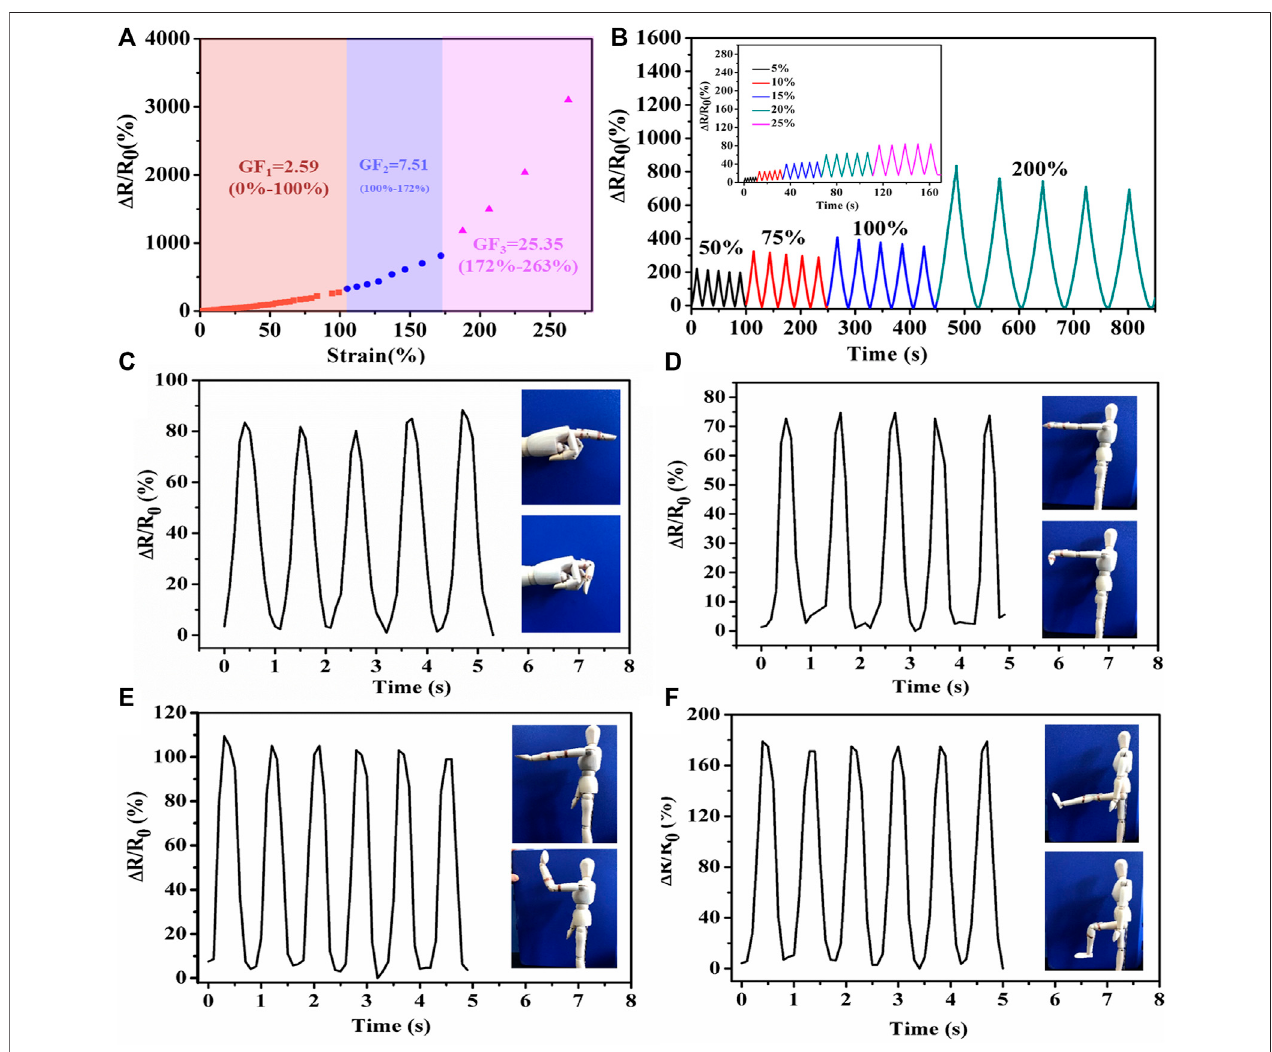
FIGURE8| SensingperformanceofPHEAA-GE-Gl-LiClorganohydrogel-based strainsensorat − 40 ° C. (A) Relativeresistancechangesandcorrespondinggauge factors variation with successive tensile strain from 0 to 280%, (B) the relative resistance under different small reciprocating strains and large reciprocating strains. Relative resistance changes of imitative human joints motions: (C) fi nger bending, (D) wrist joint bending, (E) elbow joint bending, and (F) knee joint bending at − 40 ° C.